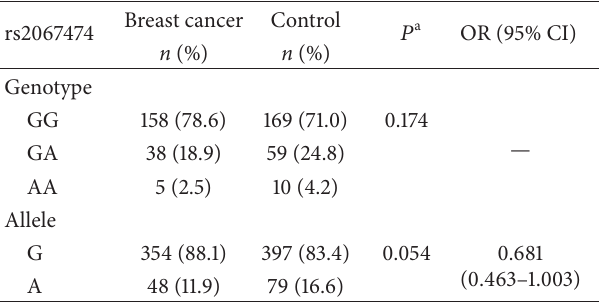
Table 2: Frequency distributions of HRH2 rs2067474 genotypes and alleleandtheirassociationswiththeriskofdevelopingbreastcancer.